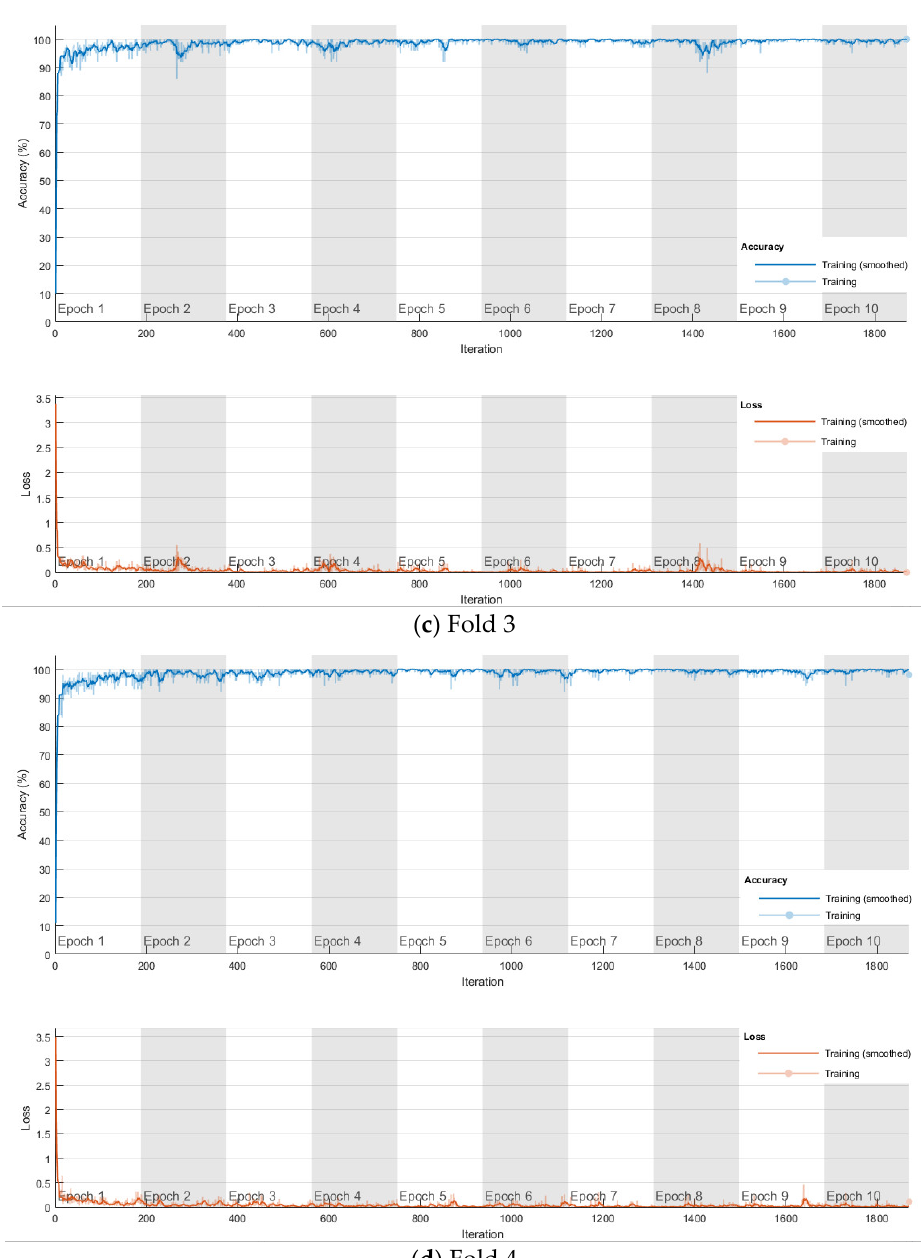
Figure 9. Training progress of the 4-fold cross-validation of the softmax classifier-based model on lung and colon cancer dataset.